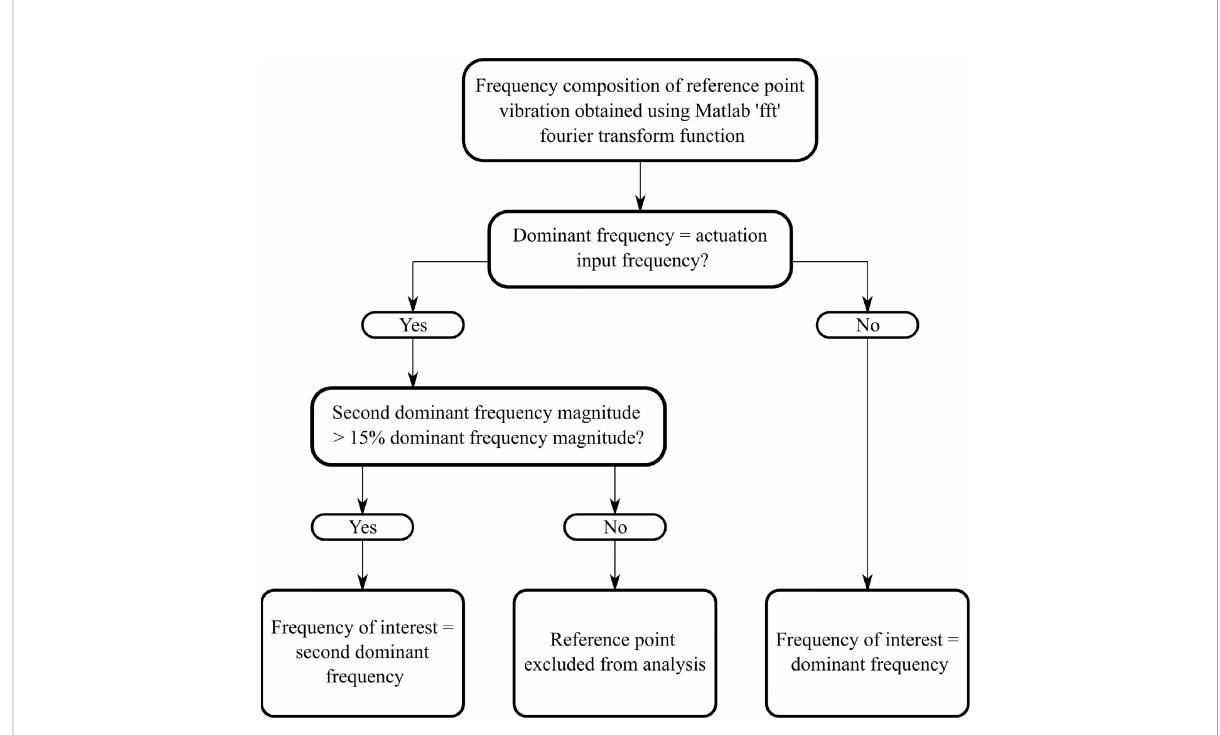
FIGURE 1 Flowchart showing method to obtain frequency of interest for each reference